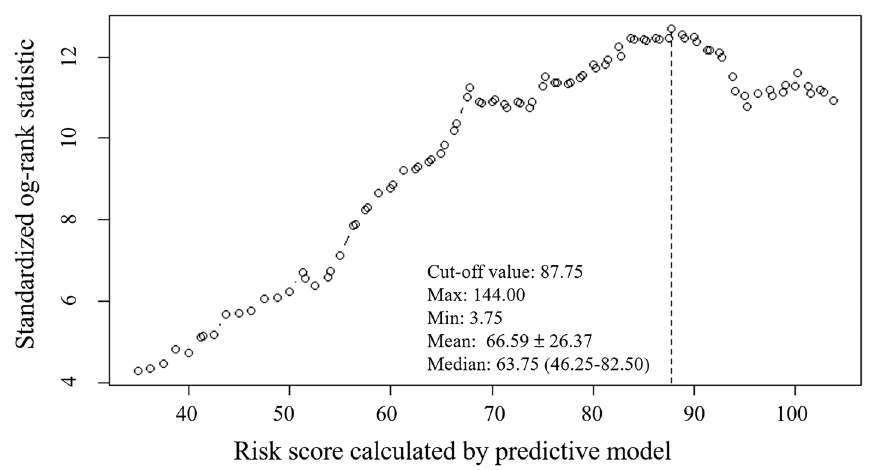
Figure 6. Distribution of risk scores and its best cut-off value. Small circles represent the risk score of each patient. The dotted line represents the location of the cutoff value (cutoff value = 87.75). Graphics were generated with Maxstat R package version 0.7–25 (Hothorn T